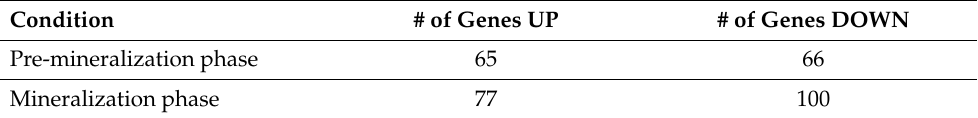
Table 3. Number of transcripts uniquely 2-fold up- or downregulated in either the pre-mineralization or in the mineralization phase of human osteoblasts